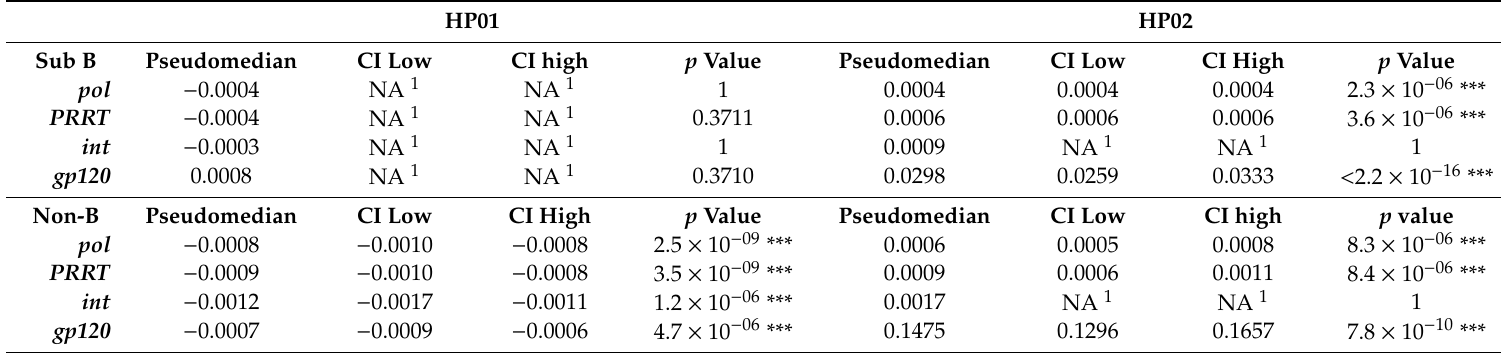
Table A1. Wilcoxon signed-rank comparisons of the adjusted genetic p-distance from the true sequence between the initial and final consensus sequences constructed in the HAPHPIPE pipelines for the simulation